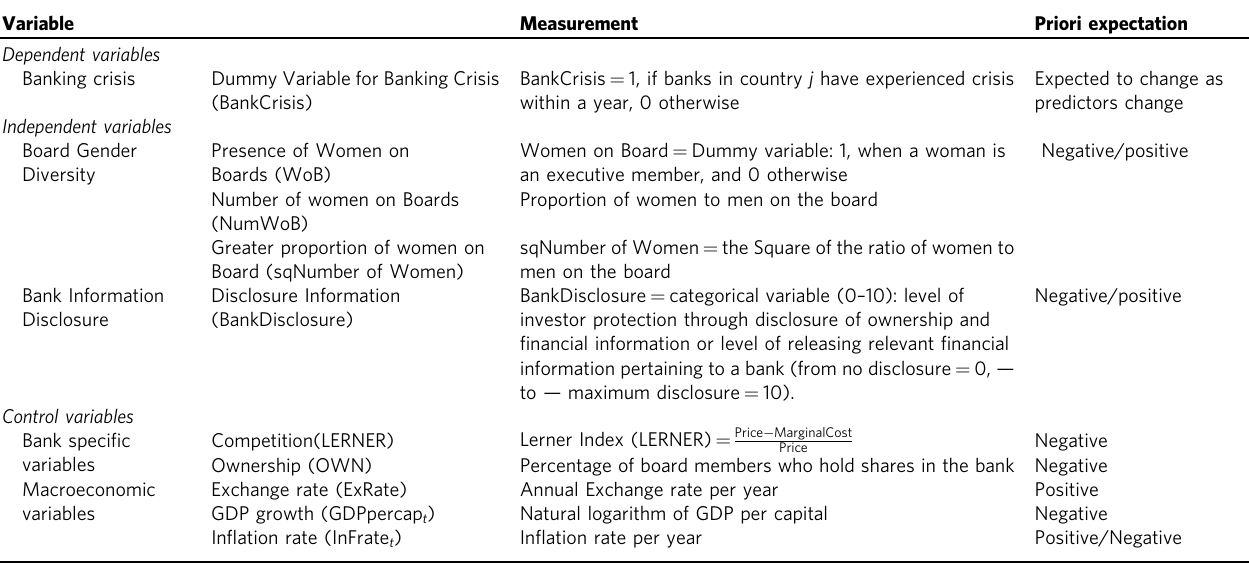
Table 1 Summary of variables.